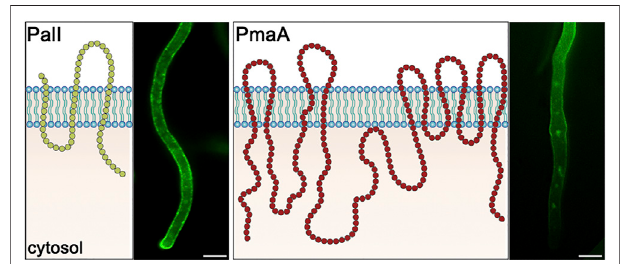
FIGURE 1 | PM topology and subcellular localization of PalI and PmaI. PalI is a 3-TMS protein, with an N-terminal signal peptide and a C-basic terminus facing the cytosol (Calcagno-Pizarelli et al., 2007). PalI-GFP appears evenly distributed to the PM with a prominent apical polarization. PmaA is a 10-TMS protein, with both termini located in the cytosol (Ferreira et al., 2001). PmaA-GFP localizes homogenously to the PM of subapical hyphal regions and is almost absent from the growing apical tip. Scale bars: 5 μ